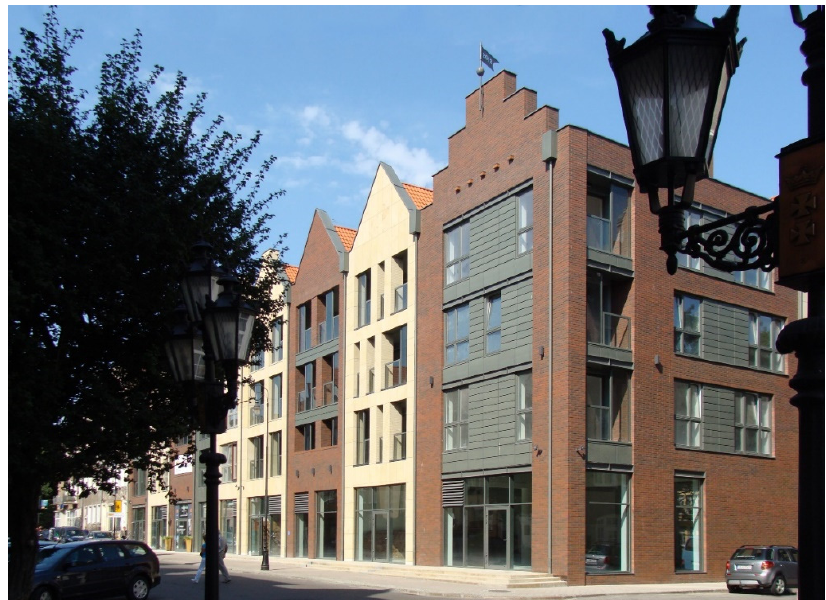
Figure 15. Tenement houses on Szeroka Street in Gda ń sk; designed by A. Taraszkiewicz. Source: A. Taraszkiewicz.